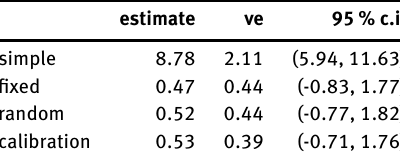
Table 4: Results: estimate, variance estimate (ve) based on 500 bootstrap replicates, and 95% confidence interval